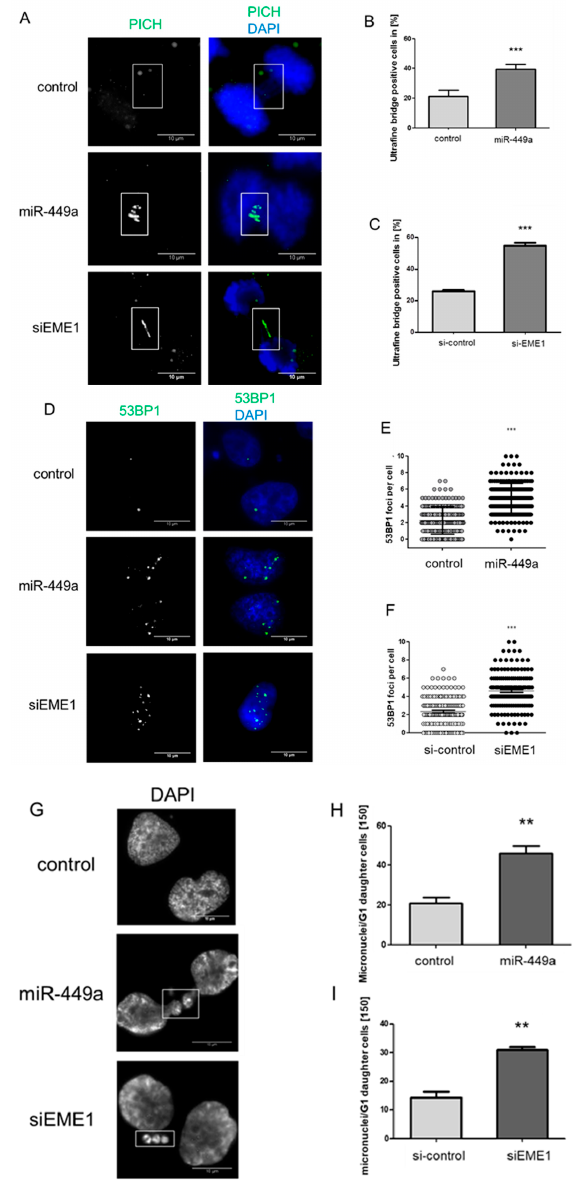
Figure 2. Induction of miR-449a expression and EME1 silencing both increase the frequency of ultrafine bridges, 53BP1 foci, and micronuclei. ( A ) Representative IF images and quantification ( B , C ) of PICH positive ultrafine bridges (green) in HCC38 cells transfected with miRNA mimics or control or with an EME1 siRNA. DNA was stained using DAPI (4 ′ ,6-Diamidin-2-phenylindol) (blue). N = 150. ( D ) Representative IF images and quantification ( E , F ) of 53BP1 positive foci (green) in HCC38 cells transfected with miRNA-mimics or control, or with an EME1 siRNA. DNA was stained using DAPI (blue). N = 150 ( G ) Representative images of micronuclei stained using DAPI and quantifica- tion ( H , I ). n = 150. Bar graphs show mean ± SEM. Error bars represent SEM. N = 3. ** p < 0.01, *** p < 0.001, 2-tailed Student’s t -test. Scale bars = 10 µm.